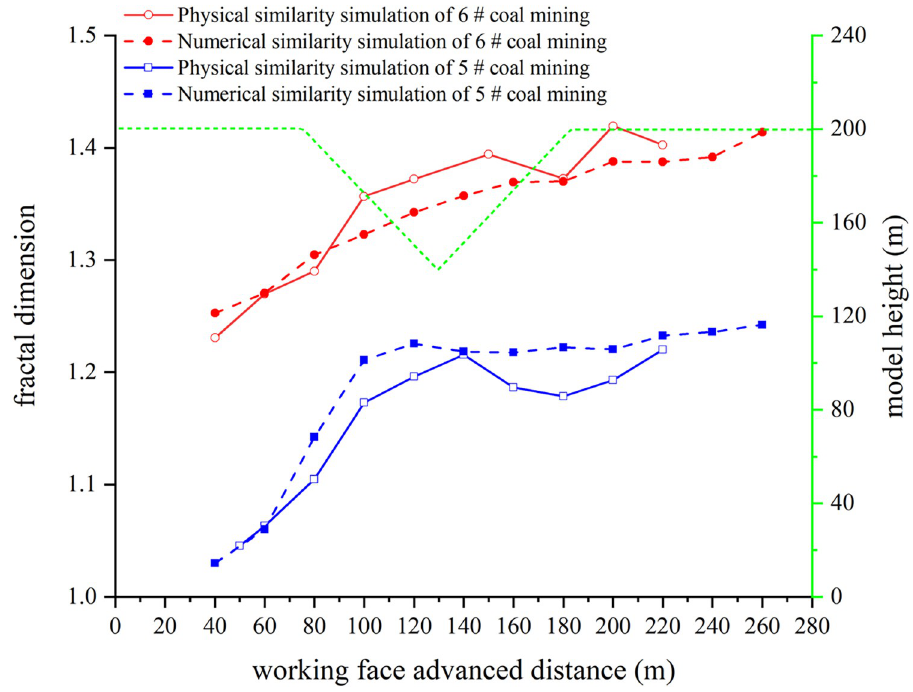
Fig 7. Line chart of fractal